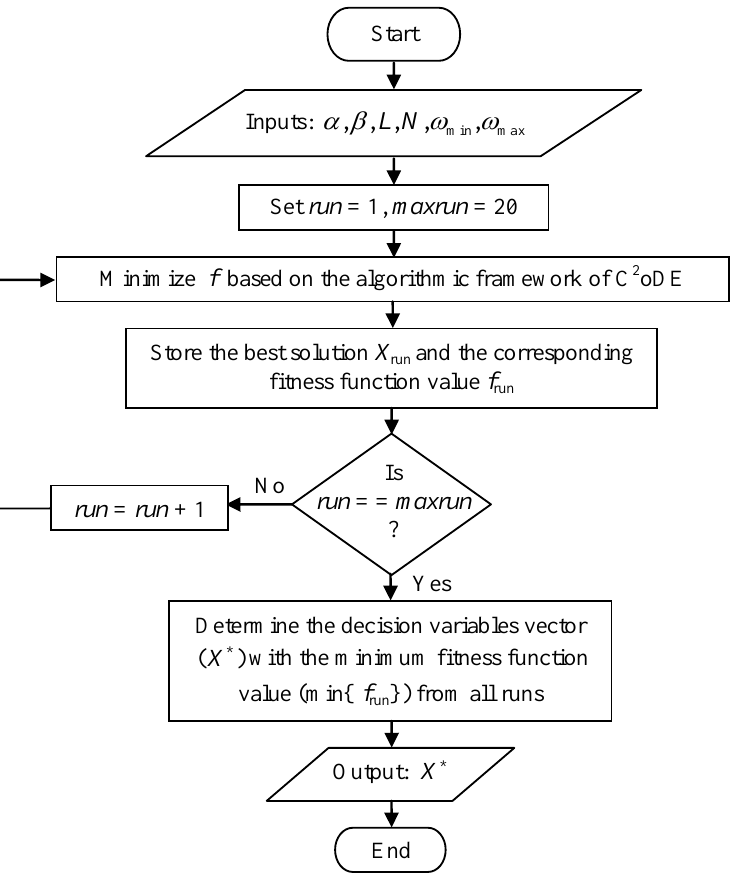
Figure 3. Flowchart of the proposed filter design